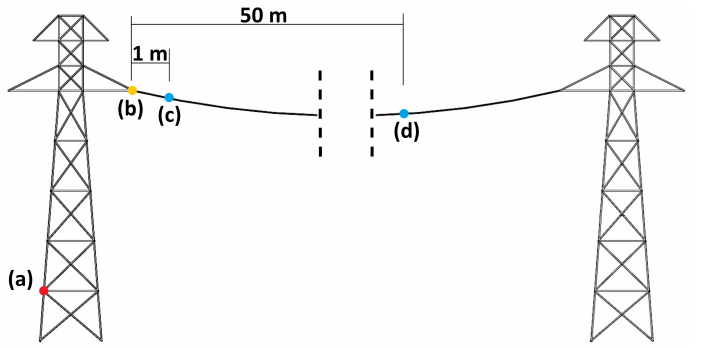
Figure 5. Span of the transmission line (100 m); point (a)—located on the tower, point (b)—the coupling point, point (c)—on the cable, 1 m from the coupling point, point (d)—located in the middle of the